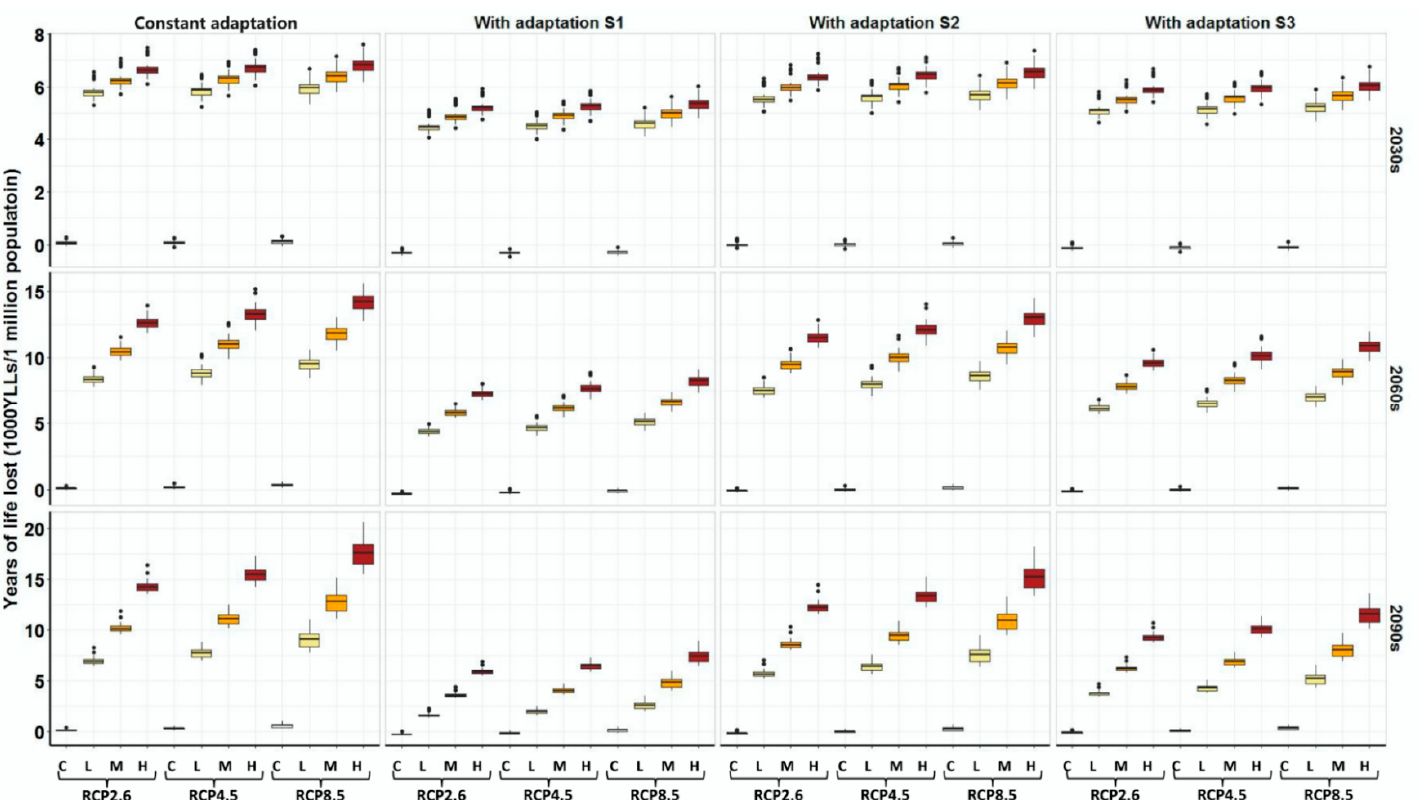
Figure 5. Impacts of aging and adaptation on the annual heat-related YLLs in the future. Constant adaptation: People’s adaptation to high temperature will remain constant at the 2010 level. Adaptation S1: People’s adaptation to high temperature will increase by 8.92% per decade. Adaptation S2: People’s adaptation to high temperature will increase by 4.60% per decade. Adaptation S3: People’s adaptation to high temperature will increase by 0.1 °C per decade. C: The population size will remain constant at the 2010 level. L: Low population expansion scenario. M: Medium population expansion scenario. H: High population expansion scenario. The three rows of panel show the effects of aging and adaptation on the heat-related YLLs in 2030s, 2060s, and 2090s, respectively. The heat-related YLLs in the future have been subtracted by the heat-related YLLs in the 1980s.